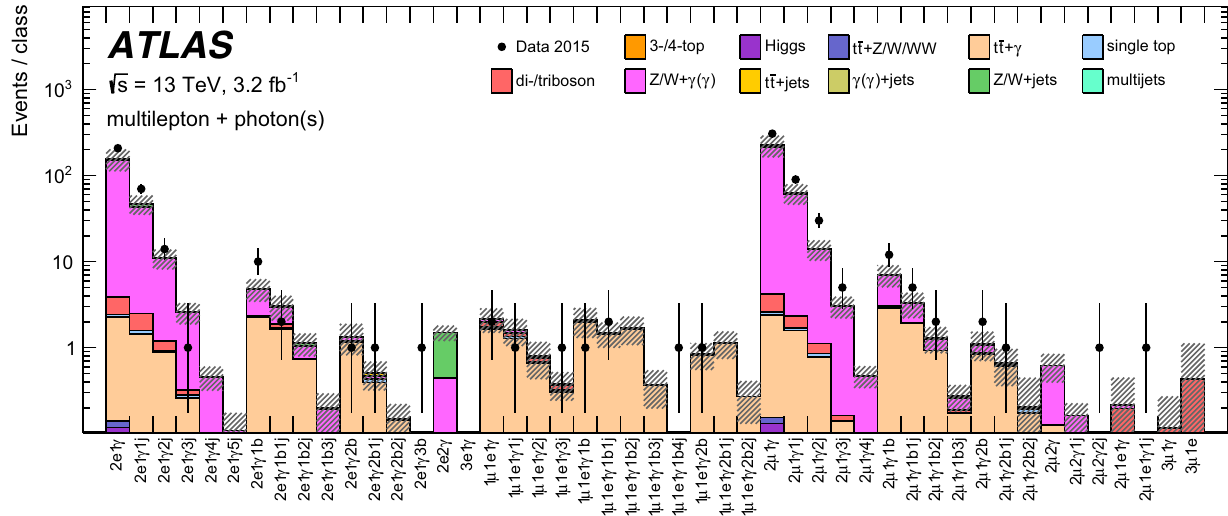
Fig. 18 The number of events in data, and for the different SM back- ing to the multiplicity and type ( e , μ , γ , j , b , E miss ground predictions considered, for classes with at least two leptons, at objects for the given event class. The hatched bands indicate the total leastonephotonand( b -)jets(no E miss uncertainty of the SM ).Theclassesarelabelledaccord- T